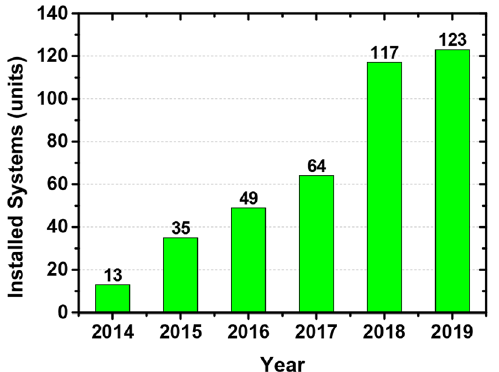
Figure 8: Estimated world market for the sold SNSPD systems (incomplete data from private